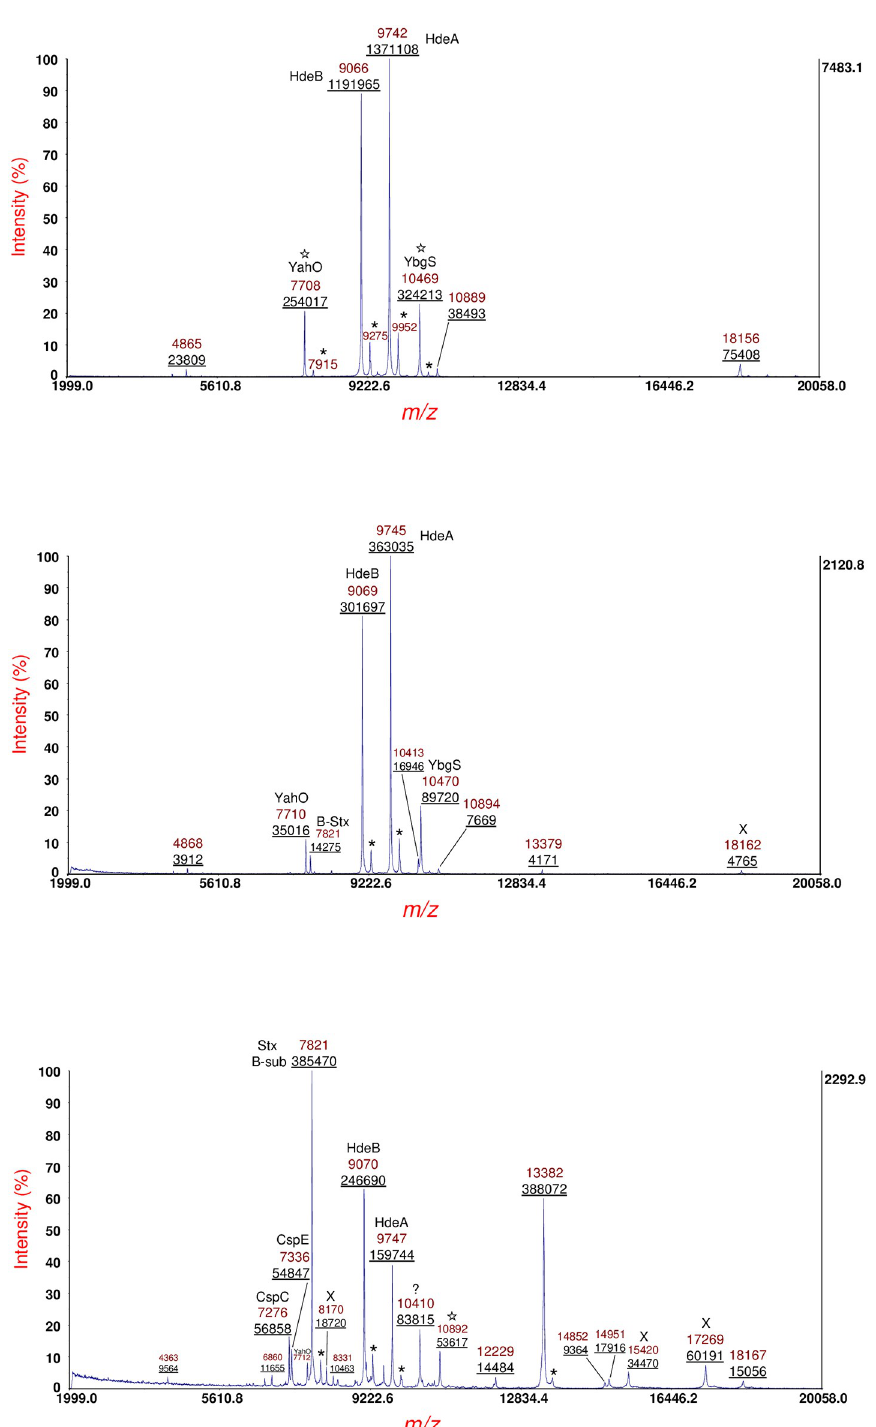
Fig 8. Top panel: MS of sample supernatant of E . coli O104:H4 strain RM14735 (German outbreak strain) cultured overnight on LBA. Middle panel: MS of sample supernatant of strain cultured overnight on LBA supplemented with 10 ng/mL of ciprofloxacin. Bottom panel: MS of sample supernatant of strain cultured overnight on LBA supplemented 20 ng/mL of ciprofloxacin. Prominent protein ions are identified by their m/z and in some cases assigned based upon previous identifications of conserved E . coli proteins. Integrated peak areas (underlined) are provided below the m/z . The B-subunit of Shiga toxin 2 is detected at m/z 7821 (middle and bottom panels) and had been previously identified for this strain. Protein ions marked with an asterisk are MALDI matrix adducts. Protein ions marked with a star